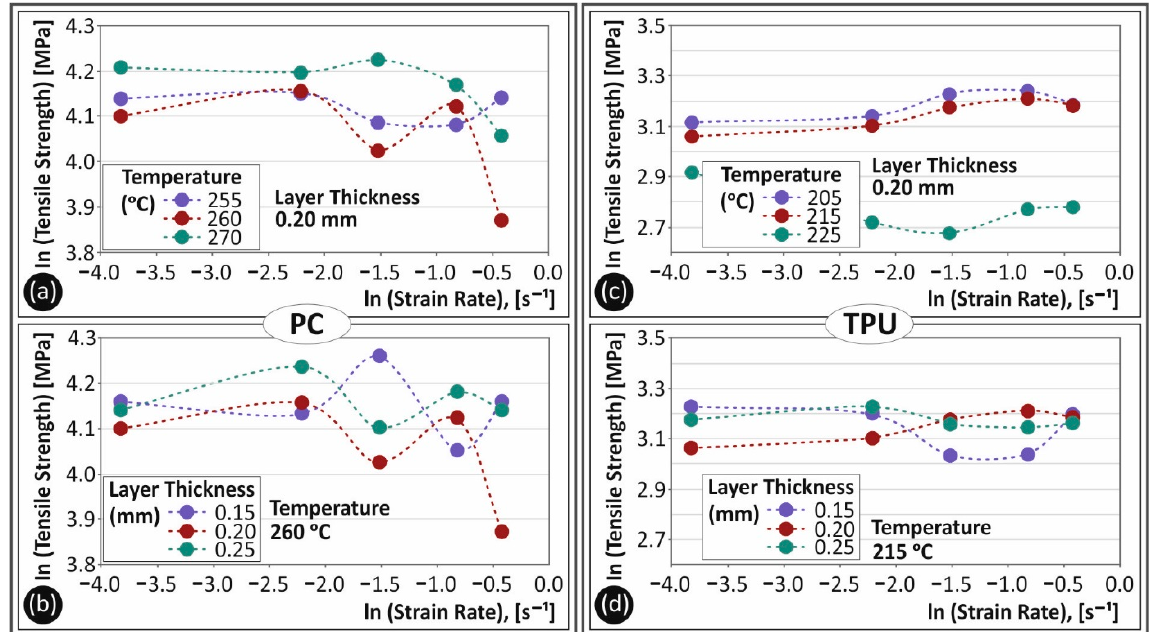
Figure 8. Ln calculated tensile strength (MPa) to strain rate (s − 1 ) for PC ( a , b ) and TPU ( c , d ) materials for the different temperatures ( a , c ) and the different layer heights (b,d) studied in this work.